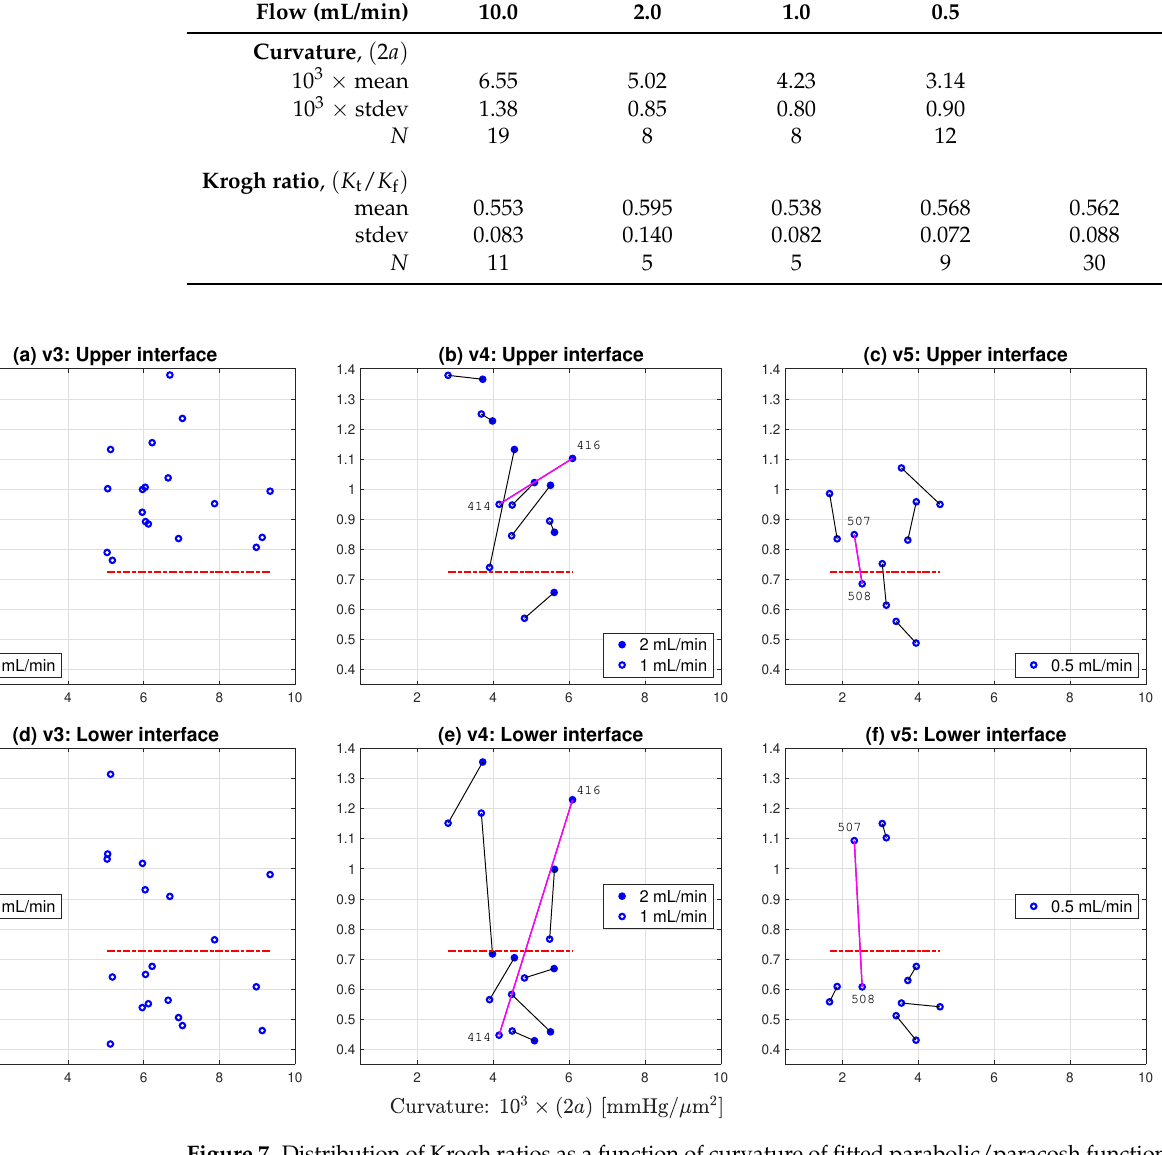
Figure 7. Distribution of Krogh ratios as a function of curvature of fitted parabolic/paracosh function. Results are clustered by dataset (three columns: v3/v4/v5) and interface (two rows: upper/lower). Dashed-red horizontal marks the selected cut-off between accepted (below red line) and rejected (above line) Krogh ratios. Scanning from left to right, lower aCSF flow rates are generally associated with reduced curvature values, implying increasingly constrained O 2 consumption. Linked pairs show repeated sampling at the same location. For v4, flow rate was set at 1 (open circles) or 2 mL/min (filled circles); for v5, flow rate was fixed at 0.5 mL/min. Outlier pairs 414/416 (v4) and 507/508 (v5) have very discrepant Krogh ratio estimates at the lower interface, possibly due to mechanical disturbance of the slice during withdrawal of O 2 probe prior to repeat sounding. See Figure 6